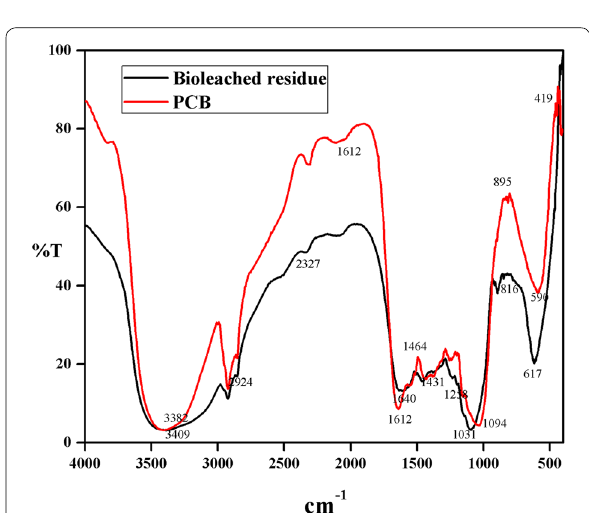
Fig. 5 FTIR spectrum of PCB and bioleaching